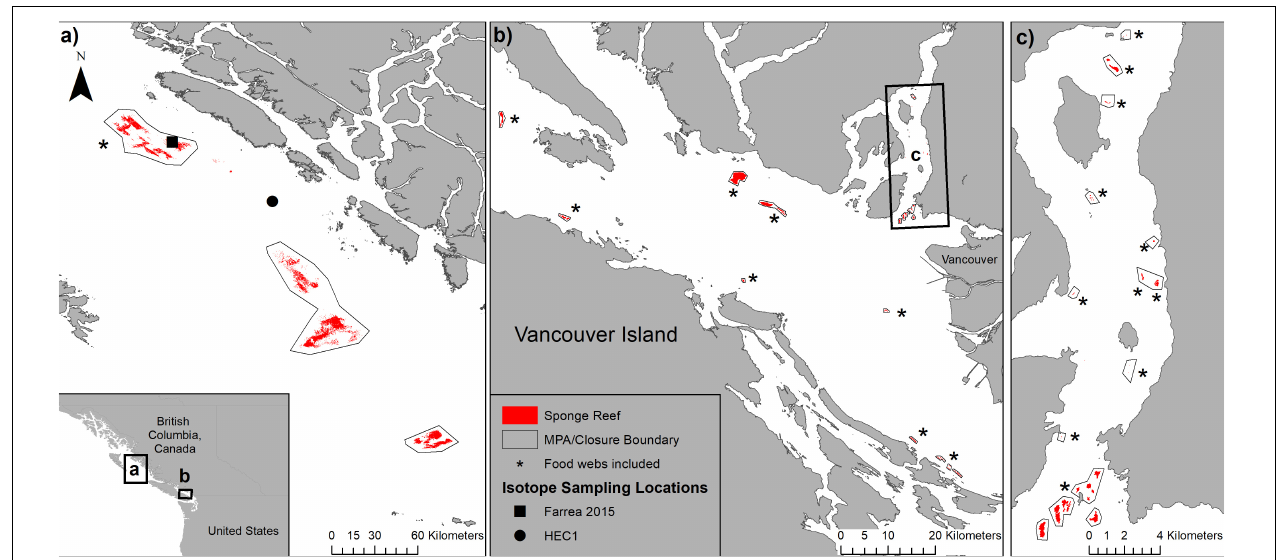
FIGURE 1 | Location of the sponge reefs and sampling sites: (a) Hecate Strait and Queen Charlotte sound glass sponge reefs marine protected area, (b) Strait of Georgia sponge reefs, and (c) sponge reefs in Howe Sound. Food webs from sponge reef complexes marked with an * were included in this study. Samples for stomach content analysis and stable isotopes were collected from Farrea 2015 and HEC1 within the Northern Sponge Reef complex within Hecate